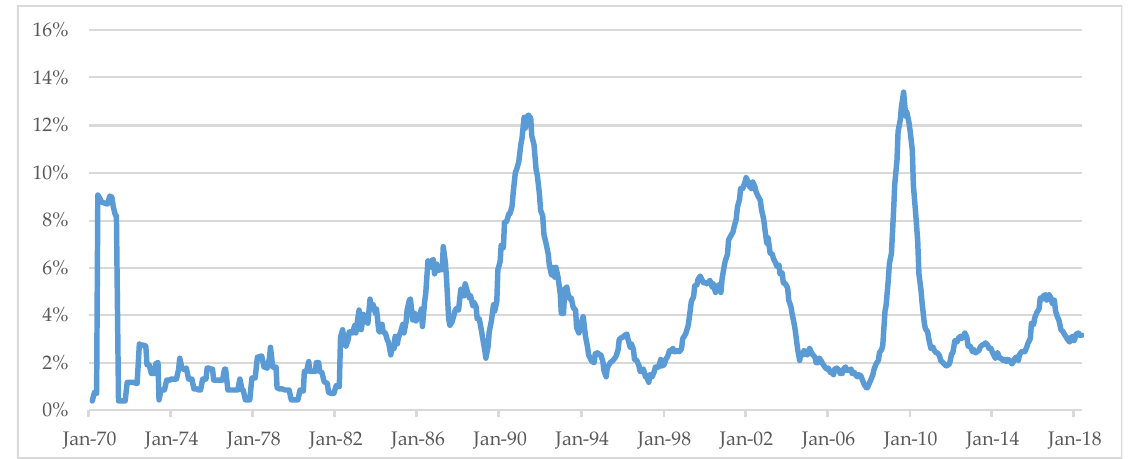
Figure 1. Global speculative-grade default rate. Source: